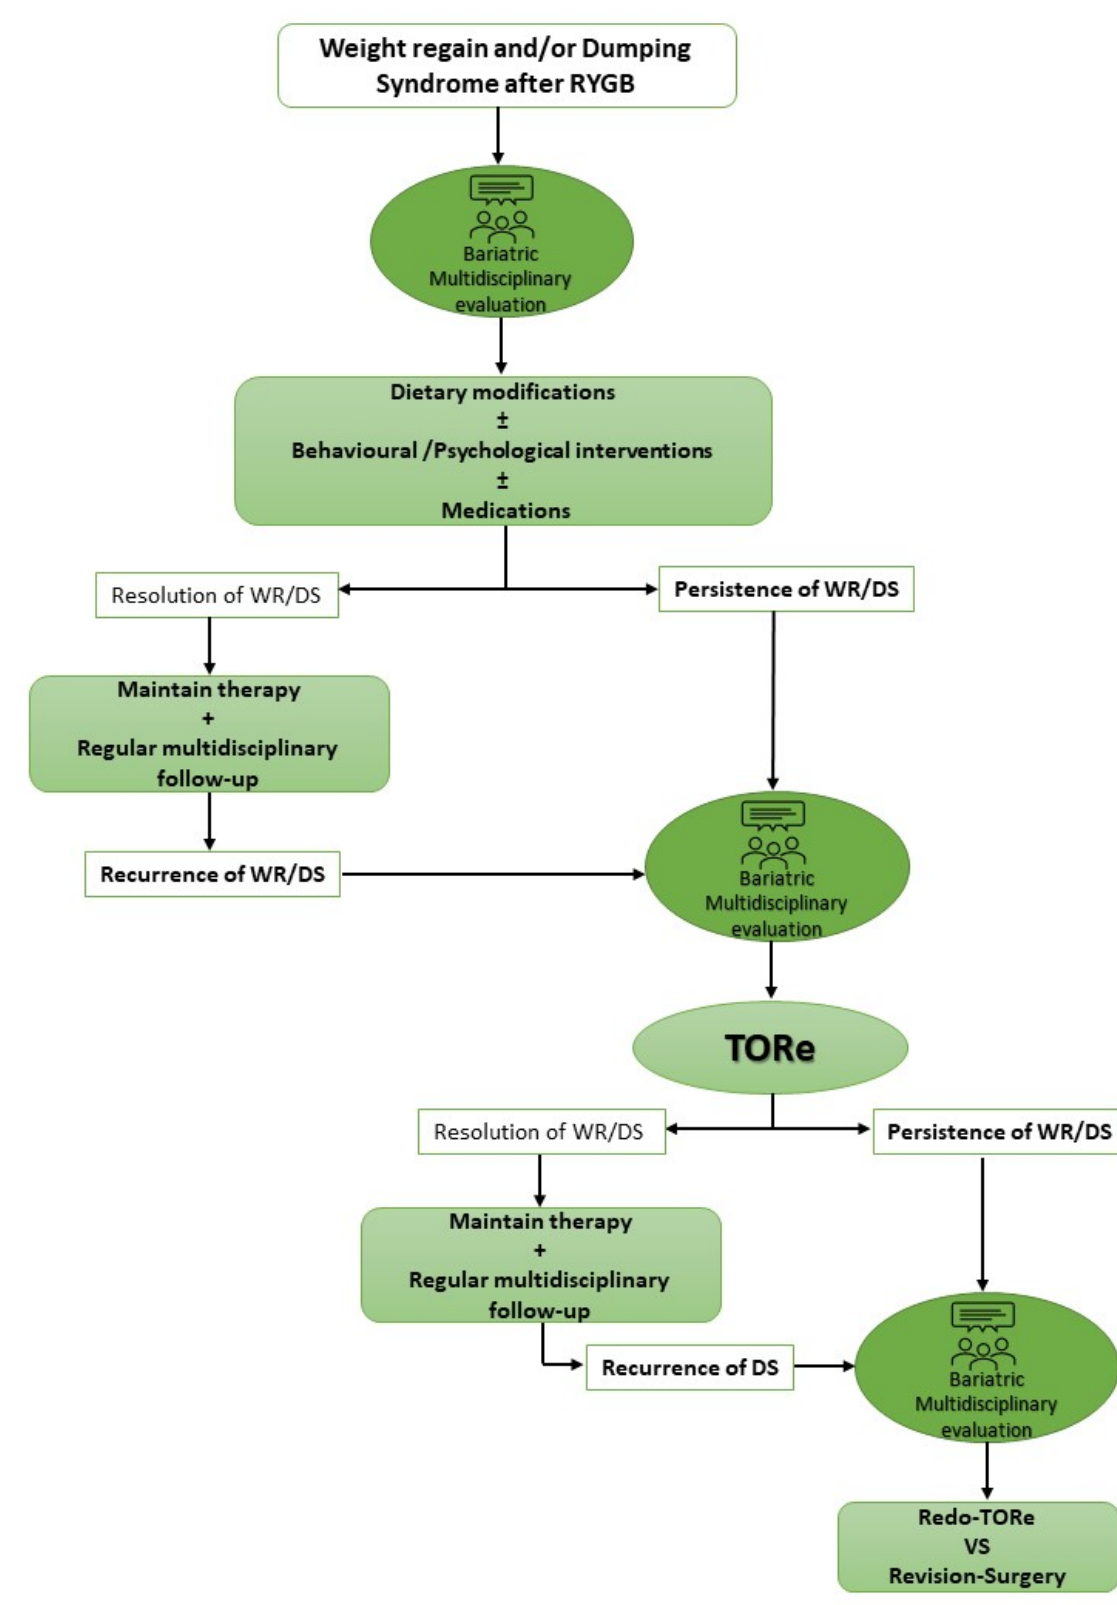
Figure 2. Proposed flow-chart for weight regain and/or dumping syndrome management after RYGB. WR: weight regain; DS: dumping syndrome; RYGB: Roux-en-Y gastric bypass; EW: excess weight; TORe: transoral outlet reduction.